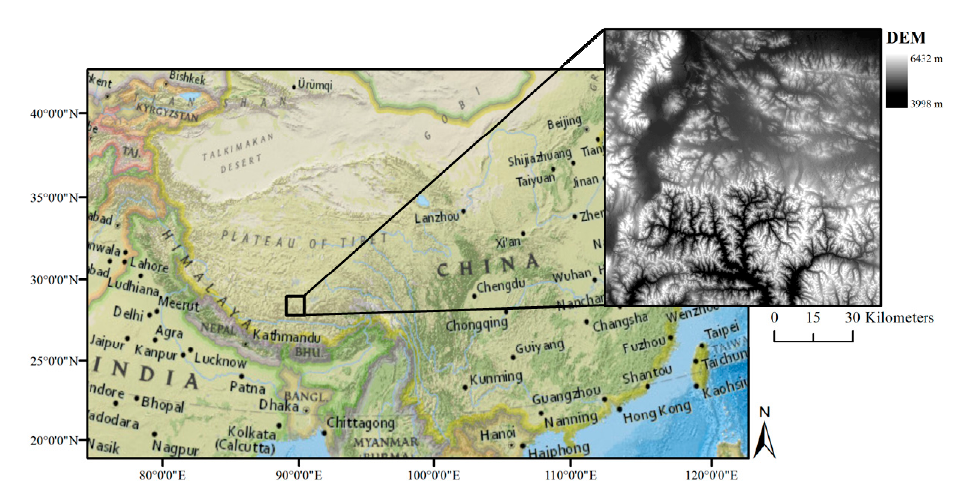
Figure 1. The Tibetan Plateau and the study site used to test the sub-pixel topographic